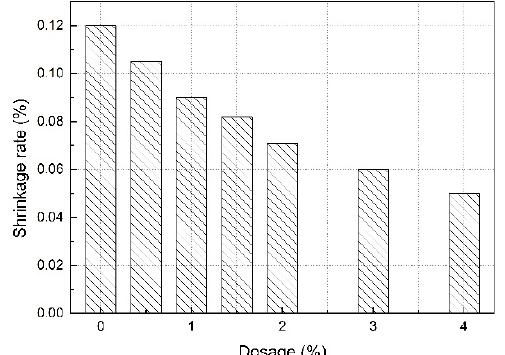
Figure 4. Shrinkage rate of SLM with different dosages of RP.